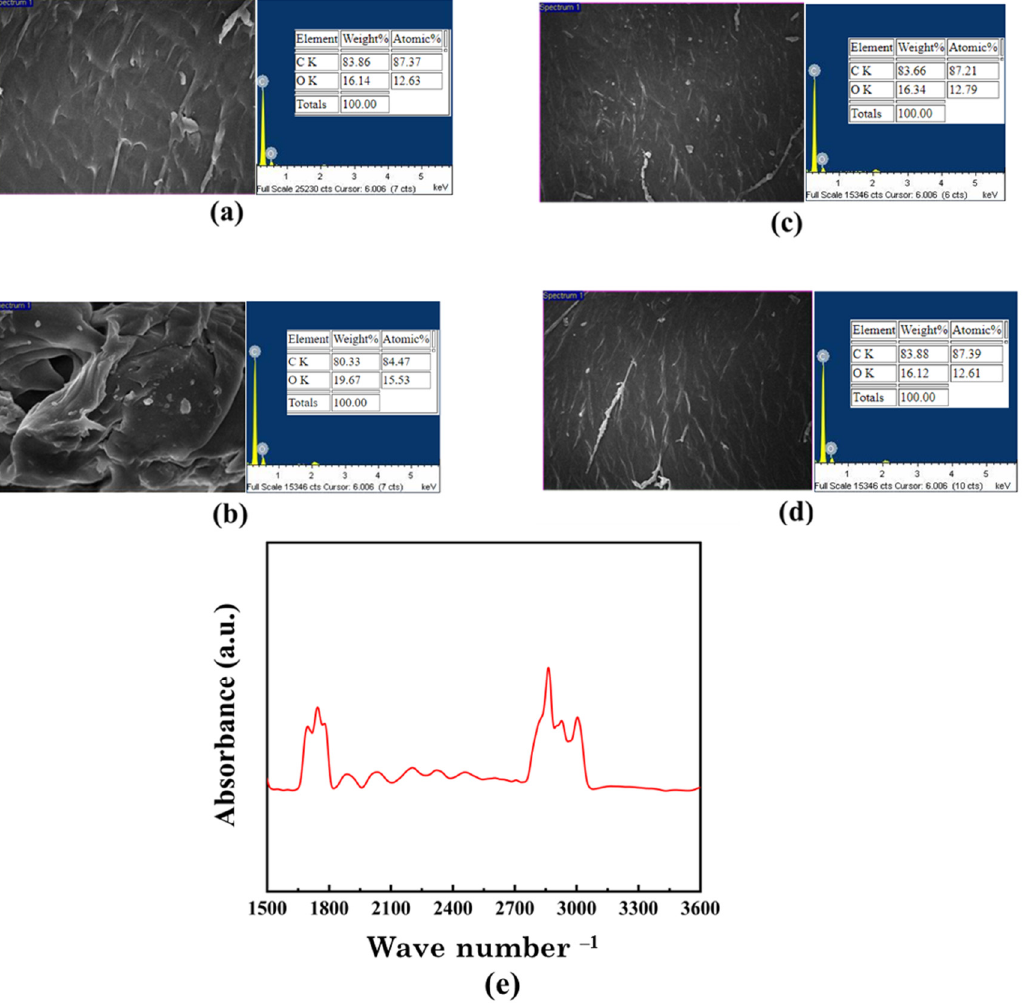
Figure 5. FE-SEM images and EDX analysis of EVA. EVA used in module having ETFE as a front sheet; ( a ) before and ( b ) after UV test. EVA used in a module having PC as a front sheet; ( c ) before and ( d ) after UV test. ( e ) FTIR image of EVA covered by ETFE after UV test.